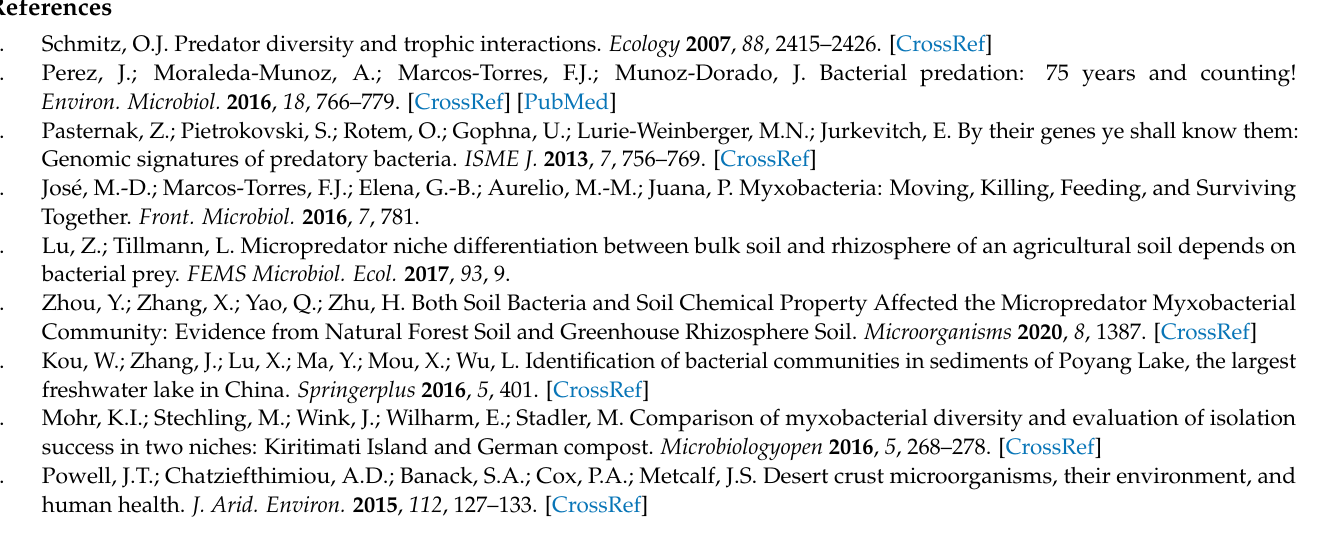
Table S1: One-way ANOVA analysis of physicochemical properties and microbial community diver- sity under different compost manure treatments; Table S2: PERMANOVA analysis of ccommunity under different compost manure treatments; Table S3: Contributions of compost parameters to the myxobacteria community composition and diversity (multivariate regression trees analysis); Table S4: Myxobacteria relative abundance for each split; Table S5: Single factor correlation network node attribute